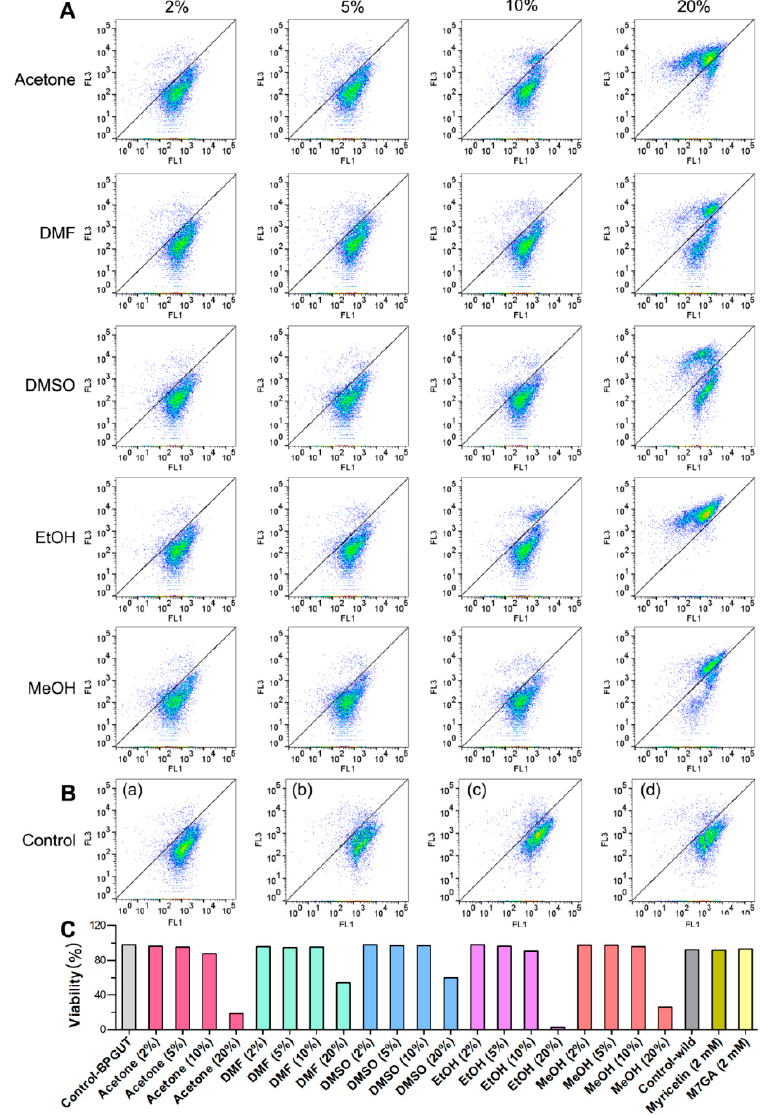
Figure 2. Viability of E. coli BPUGT cells or wild-type cells after being treated for 6 h at 30 ◦ C in a modified M9 solution containing 2% ( v / v ), 5% ( v / v ), 10% ( v / v ), and 20% ( v / v ) of organic solvents, or 2 mM of myricetin and M7GA, respectively. ( A ) Flow cytometry (FCM) images of organic solvent-treated E. coli BPUGT cells; ( B ) FCM images of untreated E. coli BPUGT cells ( a ), untreated E. coli wild type cells ( b ), myricetin-treated E. coli wild type cells ( c ), and M7GA-treated E. coli wild type cells ( d ); ( C ) The cell viability as determined by